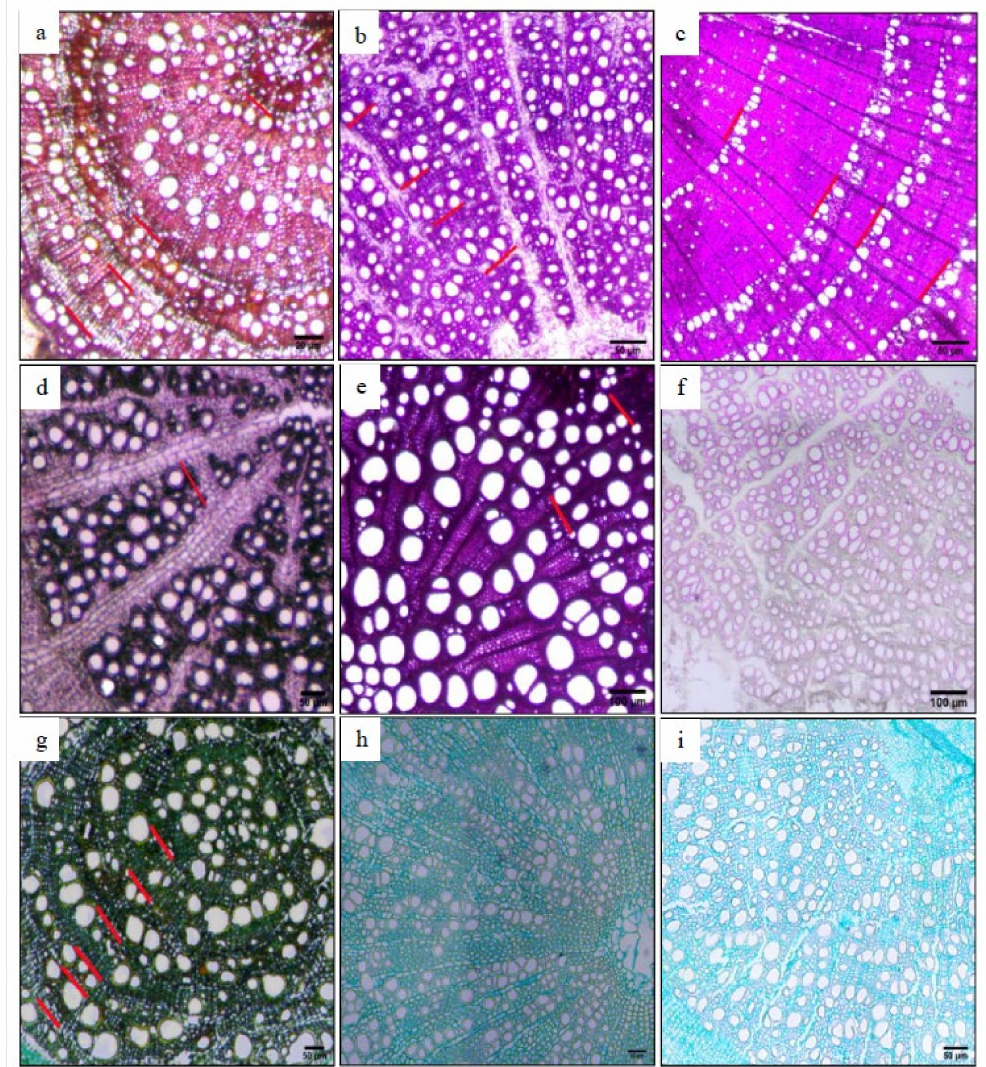
Figure 3. Fixed measured area and annual ring characteristics of the roots of Zygophyllaceae plants in arid and semi-arid areas of China. ( a ) Peganum harmala ; ( b ) Zygophyllum mucronatum ; ( c ) Sarcozygium xanthoxylon ; ( d ) Zygophyllum fabago ; ( e ) Nitraria tangutorum ; ( f ) Zygophyllum gobicum ; ( g ) Artemisia brachyloba ; ( h ) Tribulus terrestris ; ( i ) Zygophyllum potaninii . The white ellipse in the figure is the